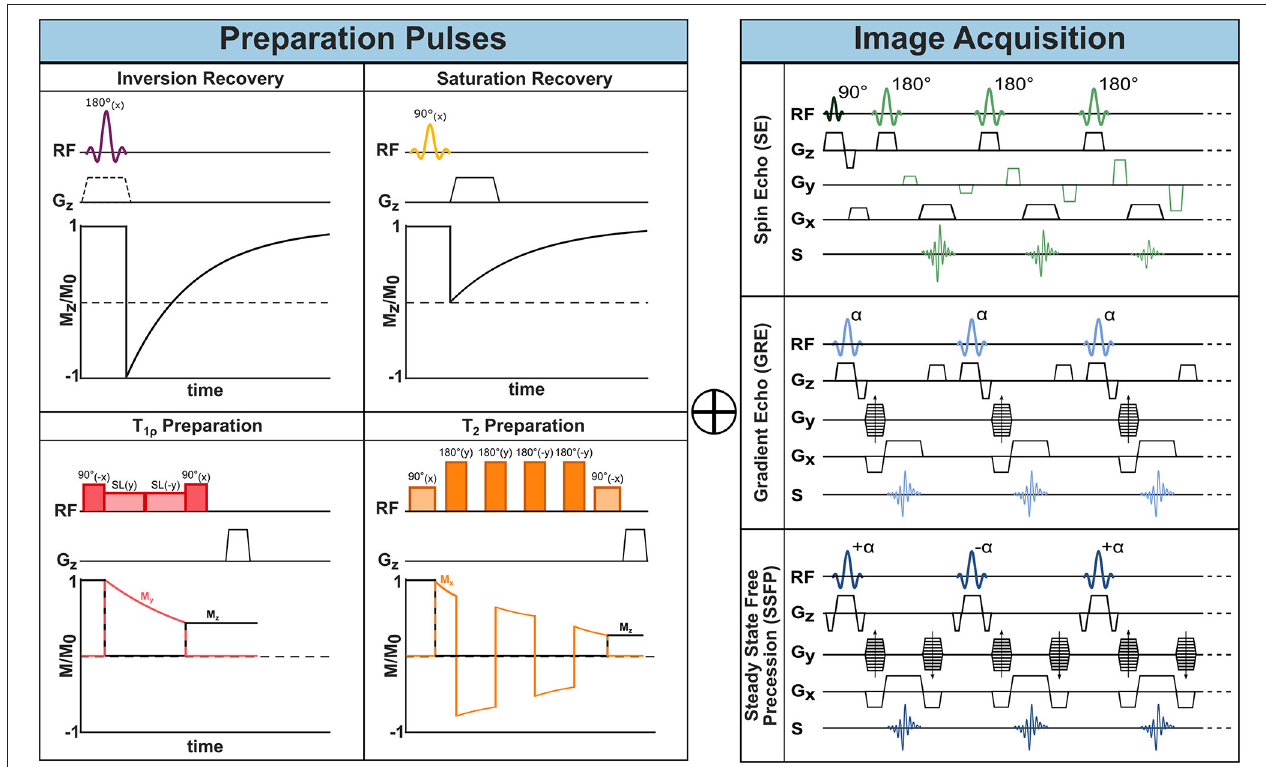
FIGURE 1 | MR sequence building blocks. One or more preparatory pulses (left) can be combined with different acquisition sequences (right) to encode the desired information into the imaging data and achieve different image